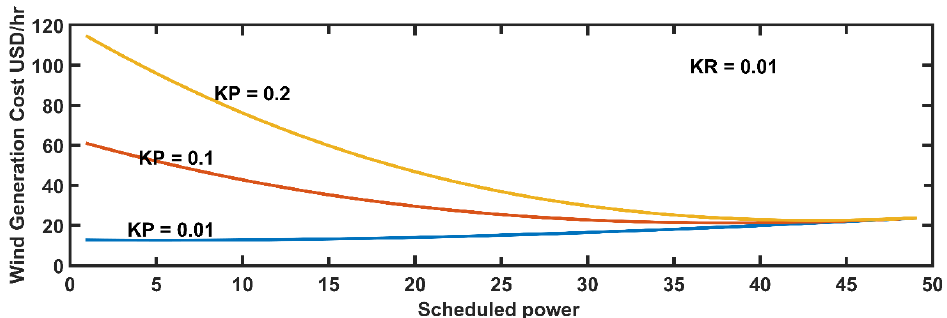
Figure 16. Wind generation cost versus scheduled power with changes of K (cid:2900) .